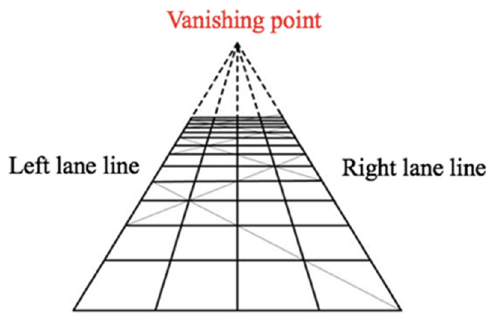
Figure 8. Vanishing point.